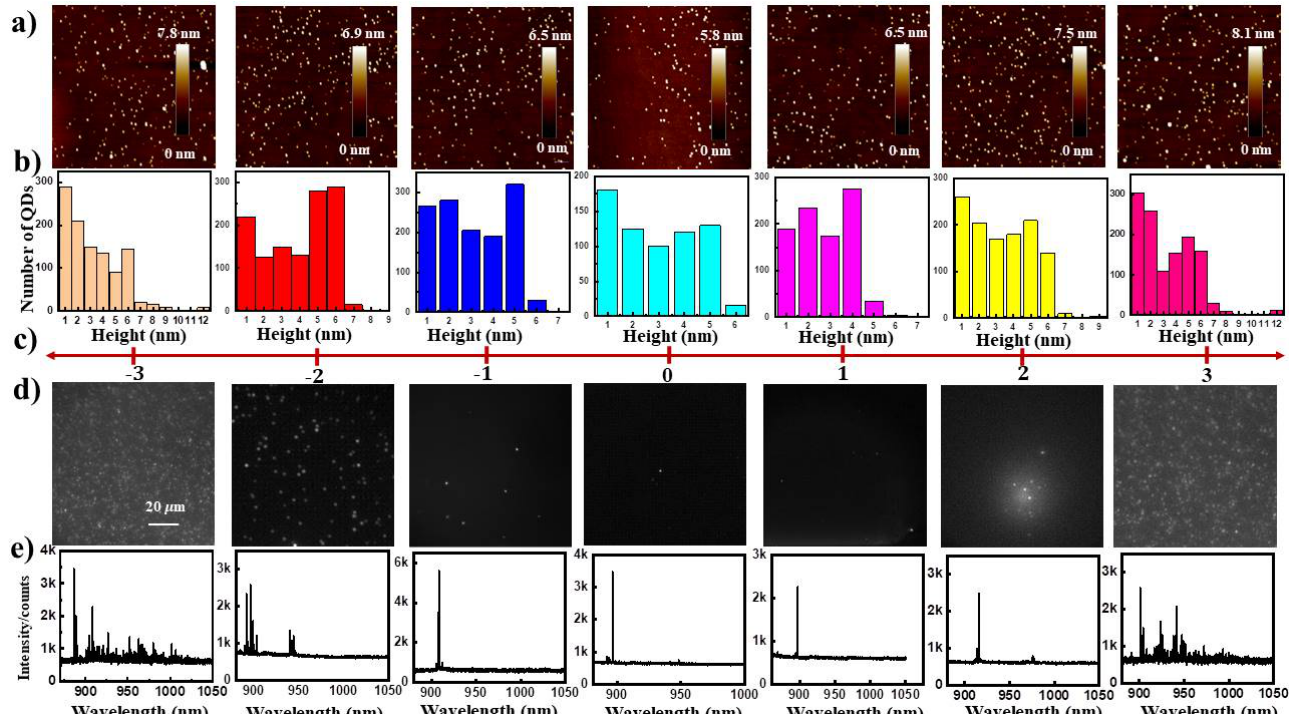
Figure 5. Both topographic, optical and statistical QD height distribution of sample H along [110] crystallographic direction, which is divided into seven regions from −3 to +3 with 1 cm interval distance, ( a ) Representative AFM images in 1 µ m × 1 µ m, ( b ) Statistical height distribution of QDs in 5 µ m × 5 µ m, ( c ) The seven regions, ( d ) Example fluorescent images from QDs measured under red LED (730 nm) illumination, a 800-nm long-pass filter (LPF) is inserted into the collection path when measuring the QD images shown in EMCCD, ( e ) the representative ensemble PL spectra under 785 nm laser